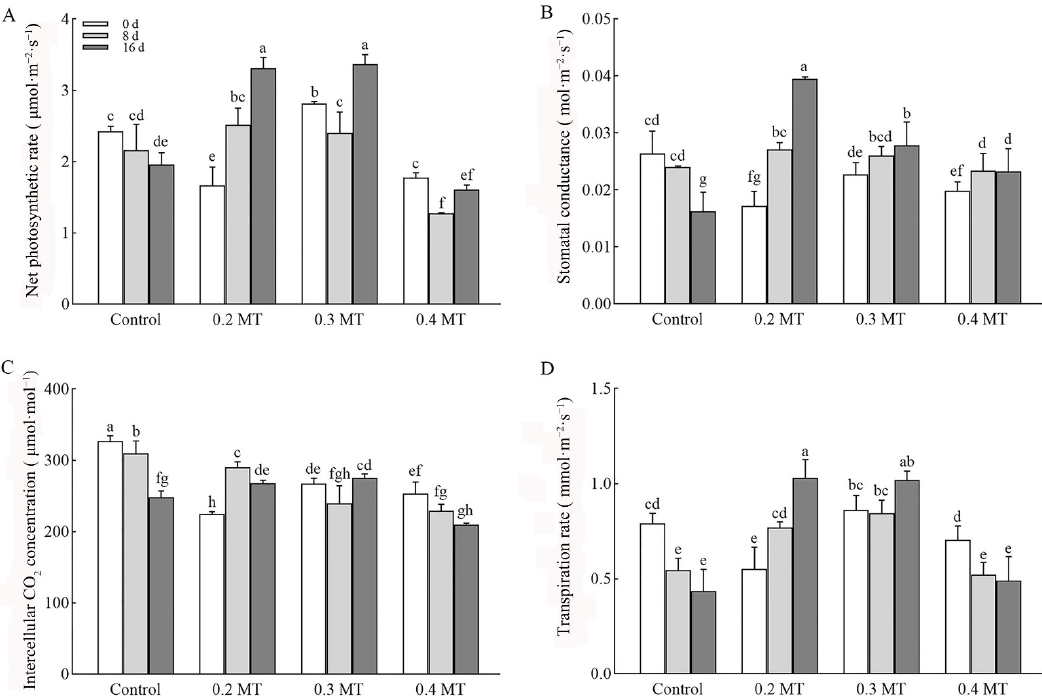
Figure 1. Effect of exogenous MT on P n ( A ), G s ( B ), C i ( C ), and T r ( D ). The tea plants were exposed to control, 0.2 mM melatonin (0.2 MT), 0.3 mM melatonin (0.3 MT), and 0.4 mM melatonin (0.4 MT). Data are shown as means ± SD in three independent replicates. Different superscript letters indicate significant differences between different treatments at p < 0.05 level.